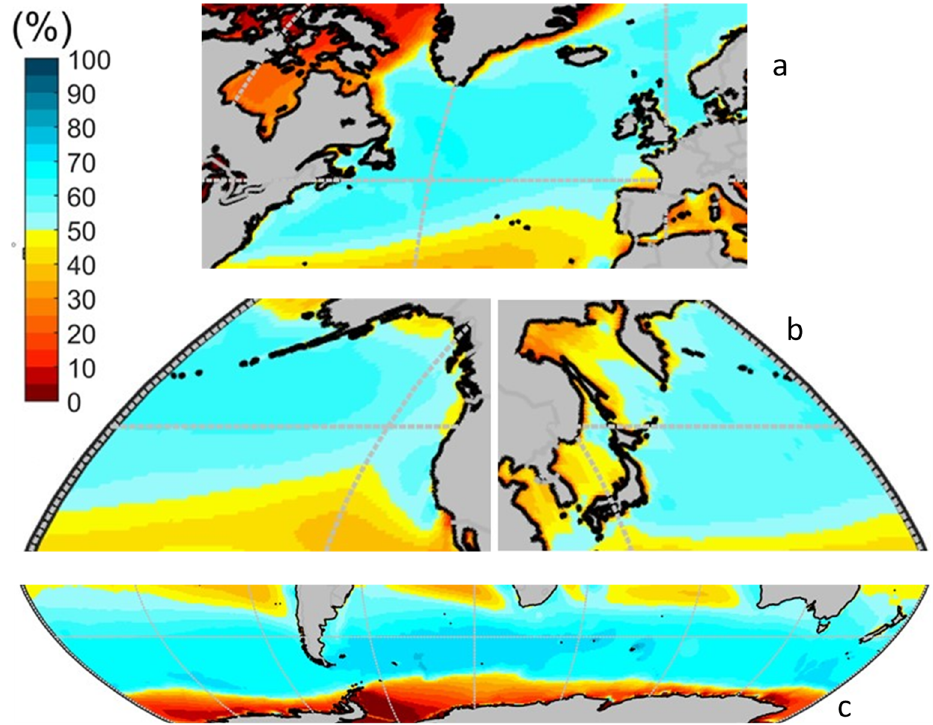
Figure 9. Polar front belts mean annual operability µ 0 . ( a ) North Atlantic, ( b ) North Pacific, ( c ) Southern Ocean.